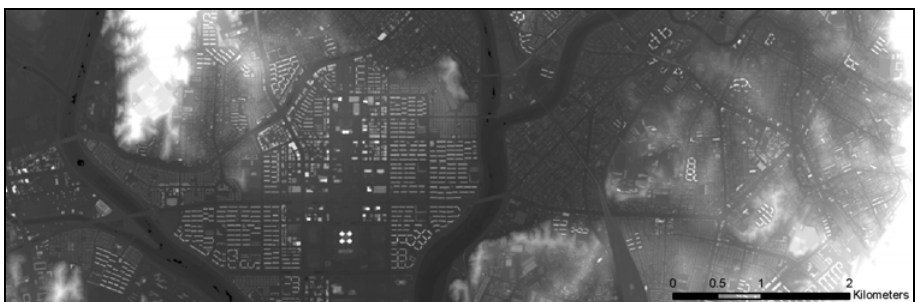
Figure 14. Raster DSM produced from dataset